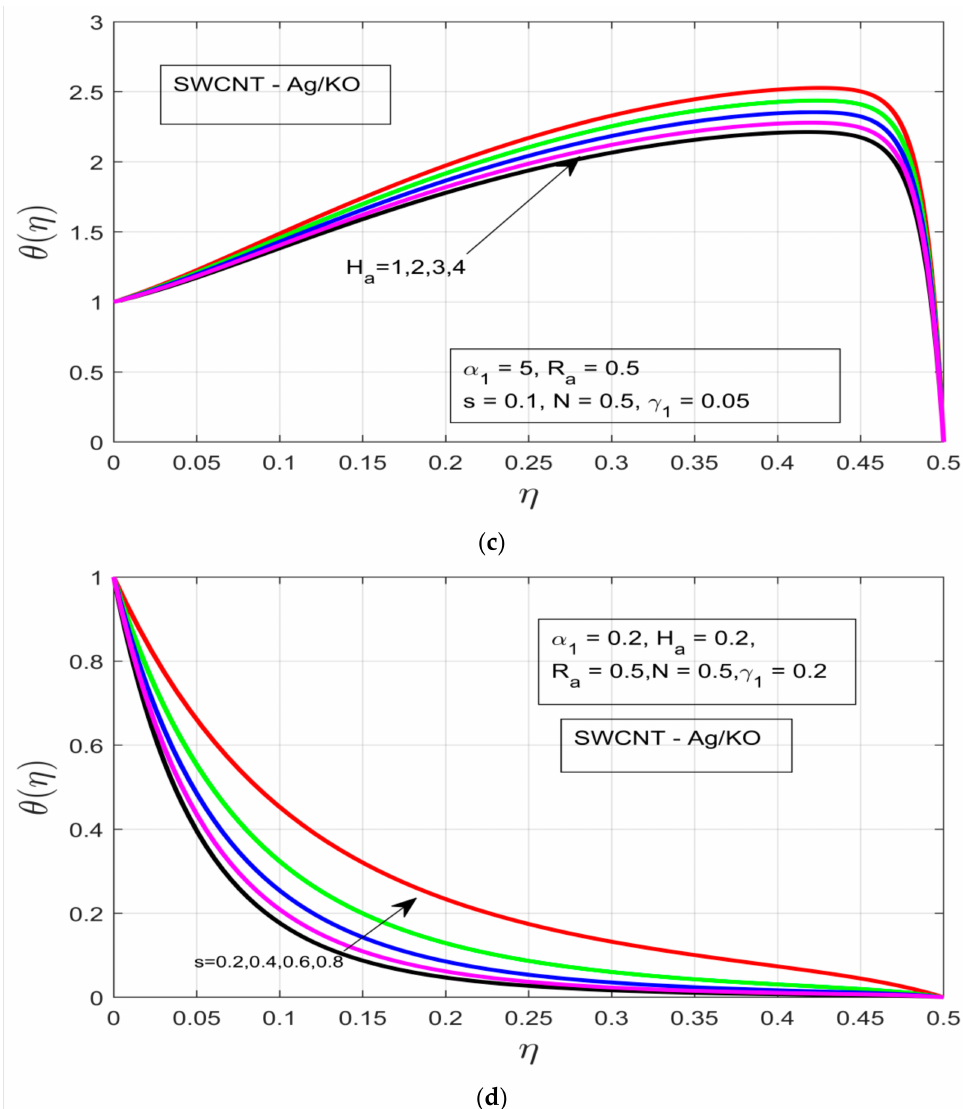
Figure 4. ( a ) Influence of the rotational ratio α 1 on the temperature profile θ ( η ) . ( b ) Impact of the buoyancy parameter γ 1 on the temperature profile θ ( η ) . ( c ) Impact of the Hartman number H a on the temperature profile θ ( η ) . ( d ) Impact of the unsteadiness parameter s on the temperature profile θ ( η )